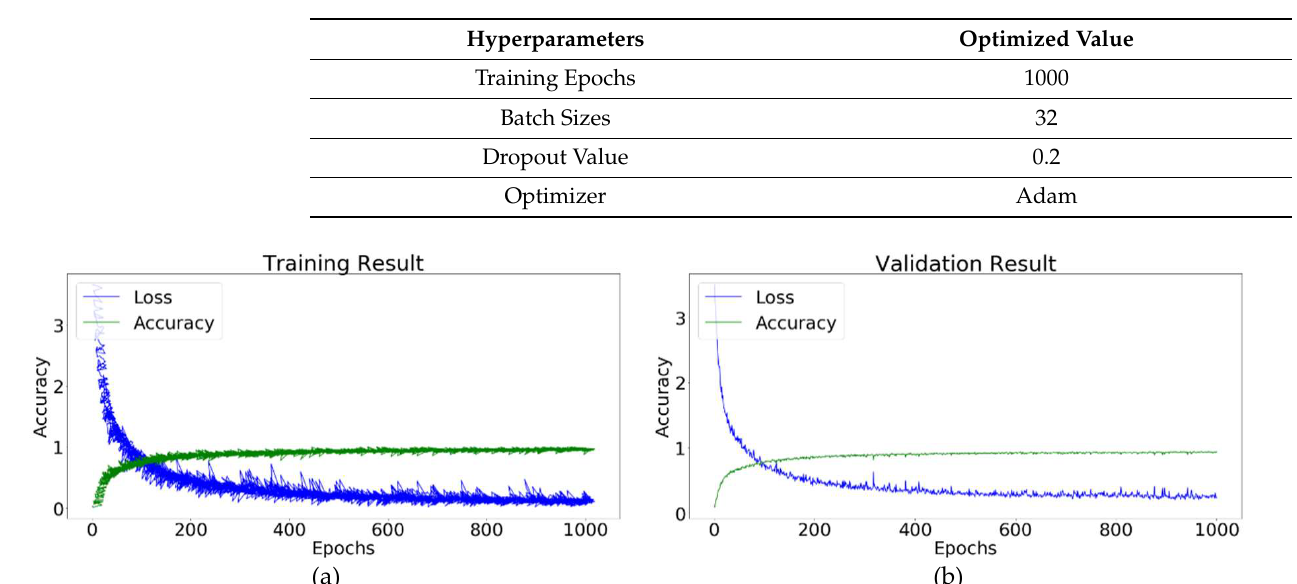
Figure 13. Conv-4 DCNN model: ( a ) Training result; ( b ) validation result.